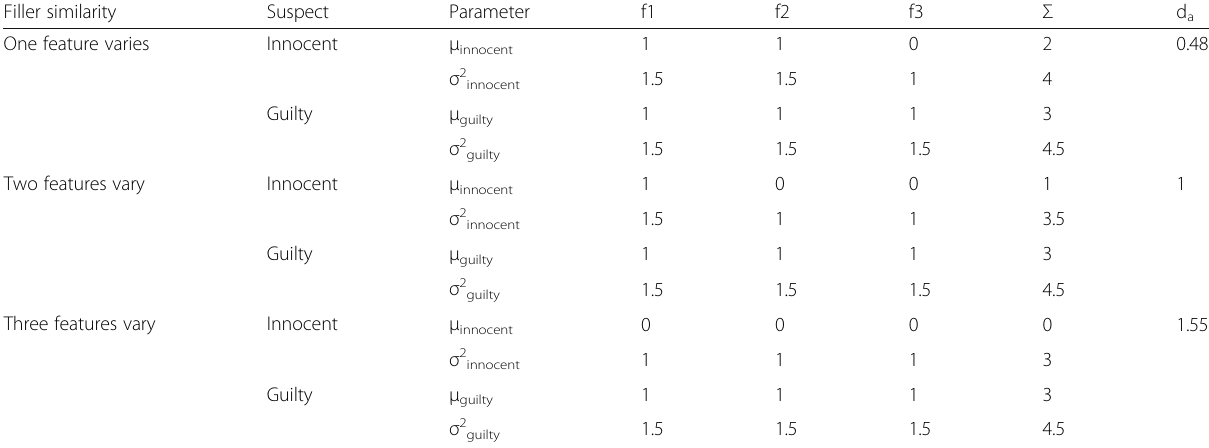
Table 1 Memory strength values of three facial features that are summed to yield an aggregate memory strength value for a face in a simultaneous lineup (adapted from Wixted & Mickes, 2014) Filler similarity